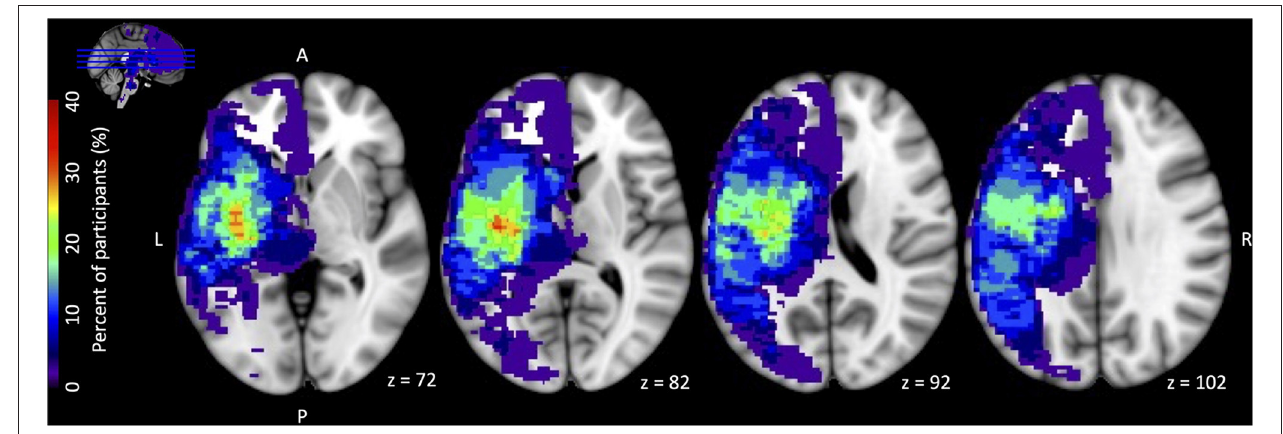
FIGURE 1 | Stroke lesion overlap heat map for all 34 participants. All lesions were flipped onto the left hemisphere for display. For the 5 participants with stroke involvement in bilateral hemispheres, the hemisphere contralateral to the affected paretic upper extremity was used for stroke location purposes. Color bar on the left has a maximum value 40% = 13 participants (maximal overlap voxel = red).